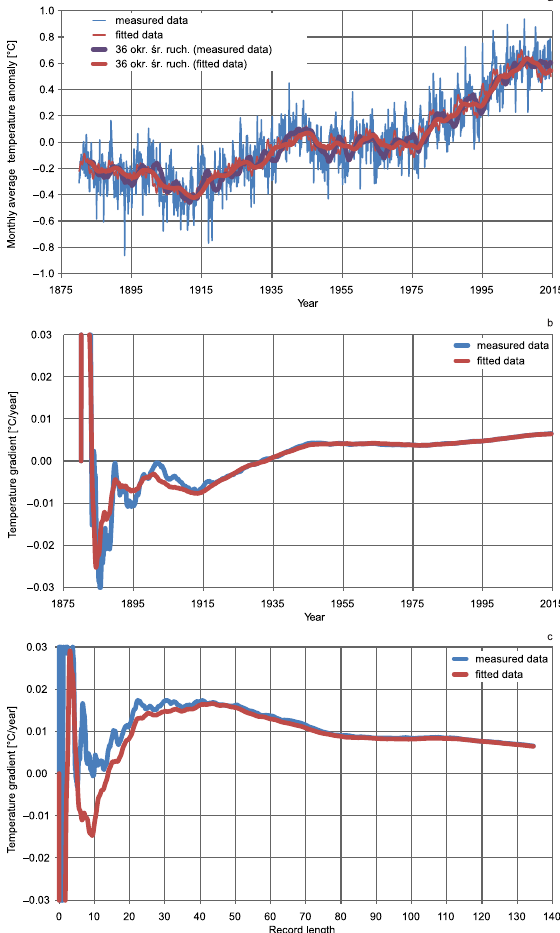
Fig. 4. Temperatures in Cape Otway Lighthouse: a) measured monthly average maximum and results obtained by a fitting with a line and sines with 36 months average trends; b) time rate of change of the monthly average maximum measured and fitted as a function of time; c) time rate of change of the monthly average maximum measured and fitted as a function of the record length. Data from Australian Government Bureau of Meteorology (BOM 2014a)